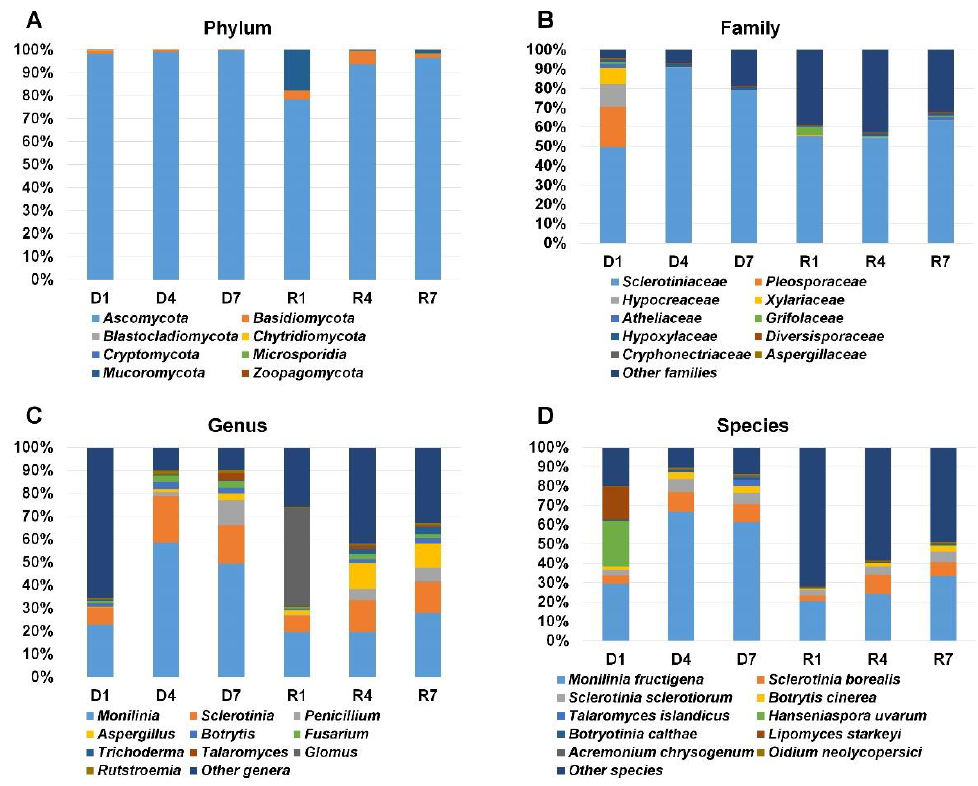
Figure 4. Taxonomy classification of identified fungi from six different libraries. Results of BLASTX using Diamond were subjected to MEGAN6 to classify taxonomy of identified organisms according to phylum ( A ), family ( B ), genus ( C ), and species ( D ). For simplicity, only a proportion of representative fungal taxonomy was visualized.